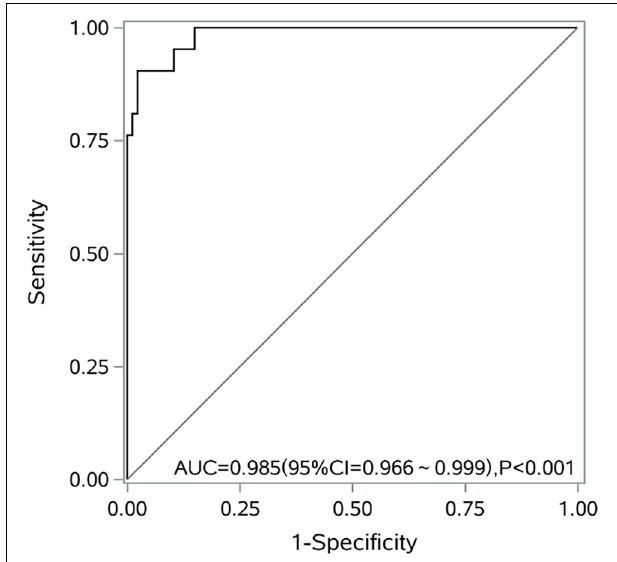
FIGURE 2 | A receiver operating characteristic curve of the logistic regression model for predicting intestinal ischemia and necrosis caused by midgut